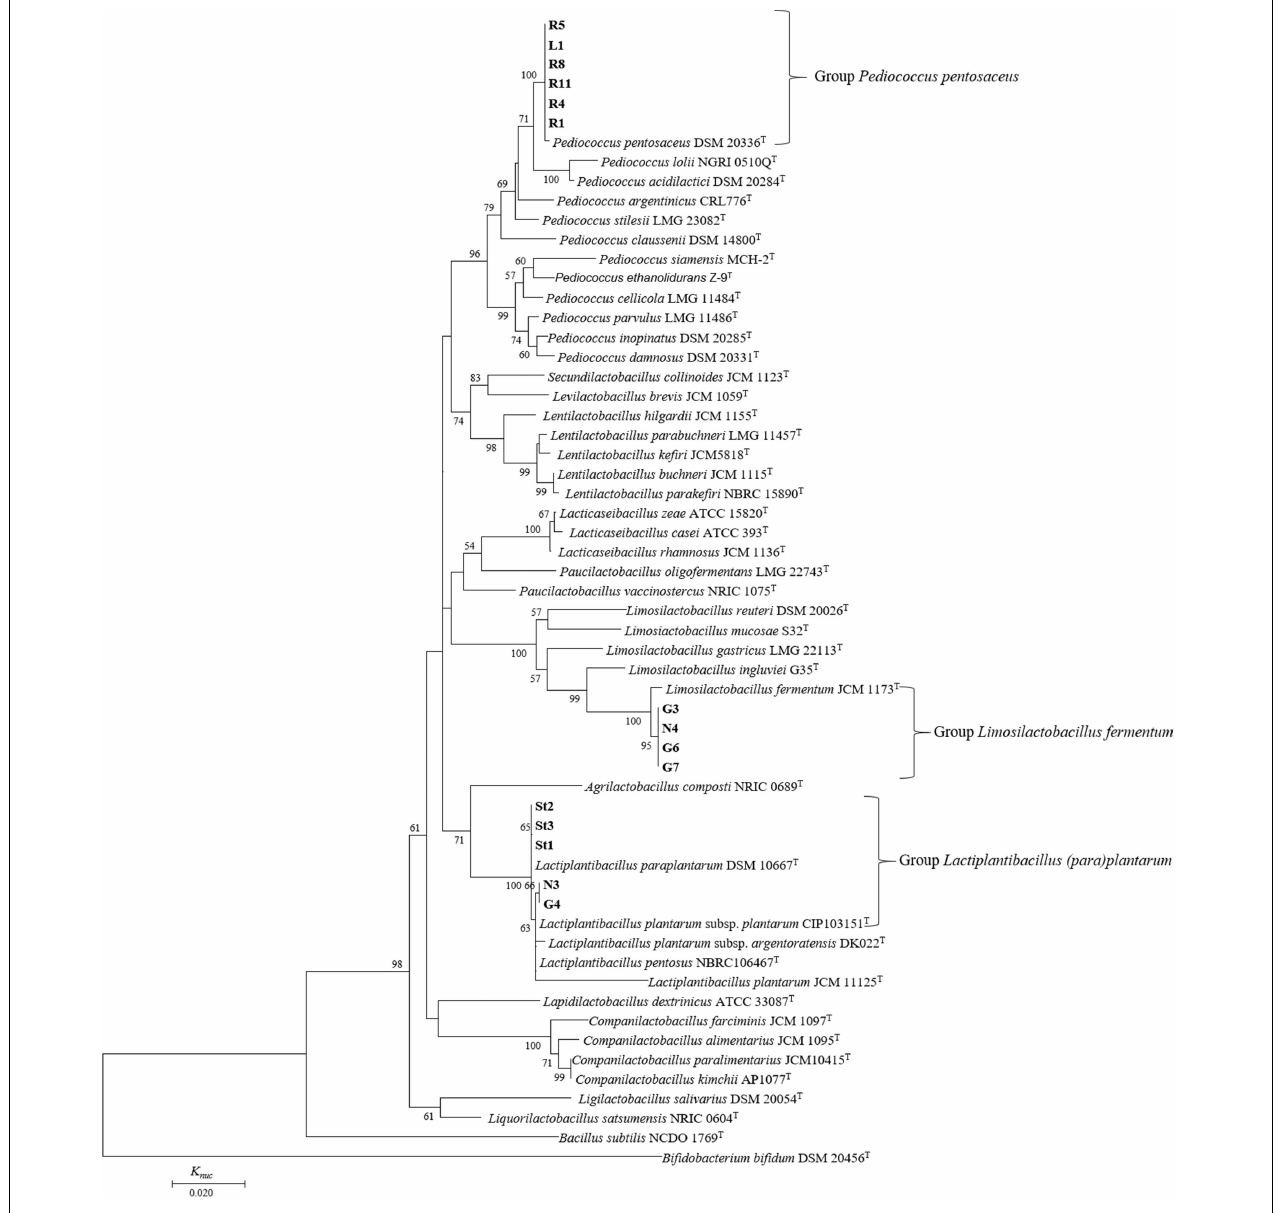
FIGURE 2 | Phylogenetic relationships of lactic acid bacteria isolated from forage-specific fermented juice of lactic acid bacteria. The phylogenetic tree based on 16S rRNA gene sequences of 831 bases was constructed by the neighbor-joining method. Numerals at nodes indicate bootstrap values (%) derived from 1,000 replications. Bacillus subtilis NCDO1769 T and Bifidobacterium bifidum DSM 20456 T were used as the